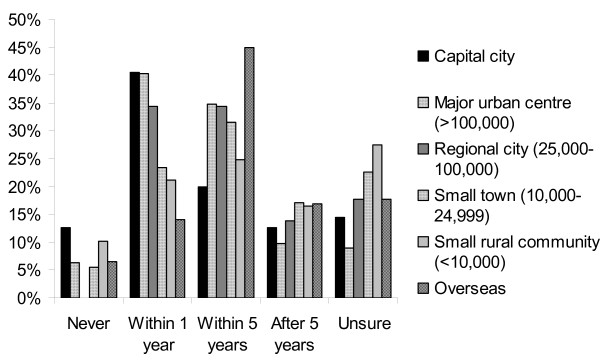
Student location preferences.